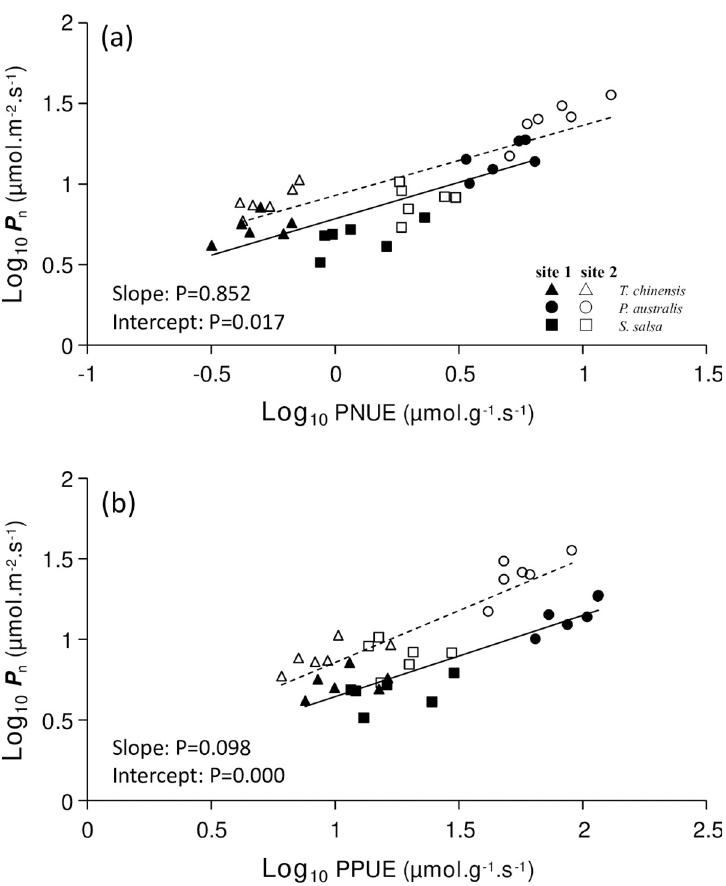
Fig 6. Relationships between photosynthetic nutrient use efficiency and P n of halophytic plant communities. (a) PNUE and P n (equation for site 1: y = 0.4522x+0.7842, R 2 = 0.679, P < 0.001; equation for site 2: y = 0.4345x + 0.9289, R 2 = 0.676, P < 0.001; with data log 10 -transformed); (b) PPUE and P n (equation for site 1: y = 0.5042x + 0.1405, R 2 = 0.812, P < 0.001; equation for site 2: y = 0.6439x + 0.2127, R 2 = 0.752, P < 0.001; with data log 10 -transformed).